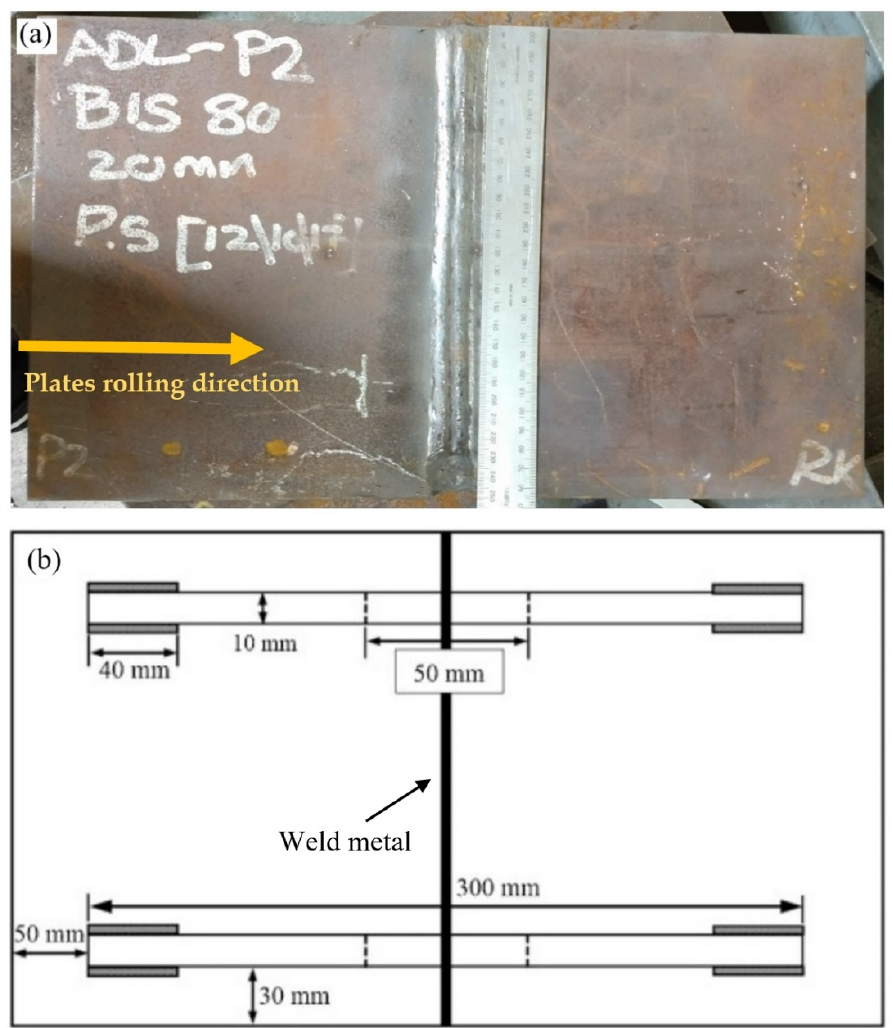
Table 1. Chemical composition for 20 mm Bisalloy 80 steel plate and the consumable wire.